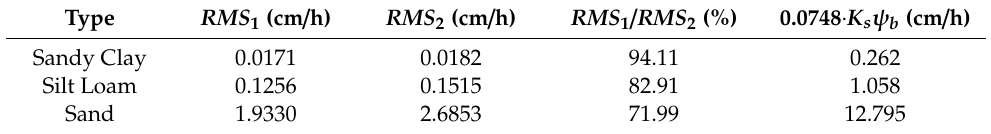
Table 3. Influence of the number of bins on the infiltration in the Talbot–Ogden